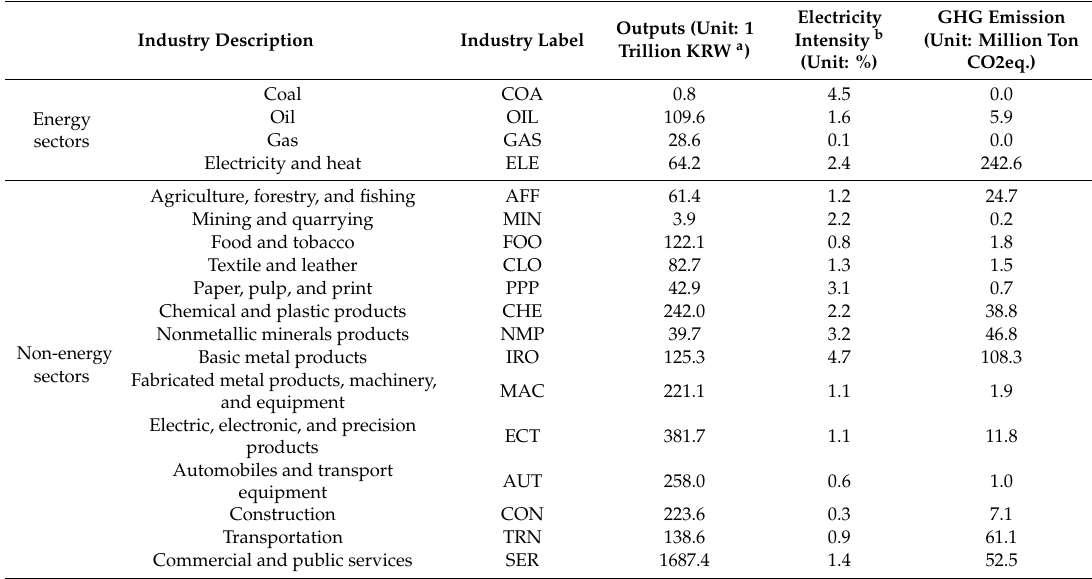
Table 3. Industry classification used in the model and descriptive statistics for each industry. Industry Description Industry Label